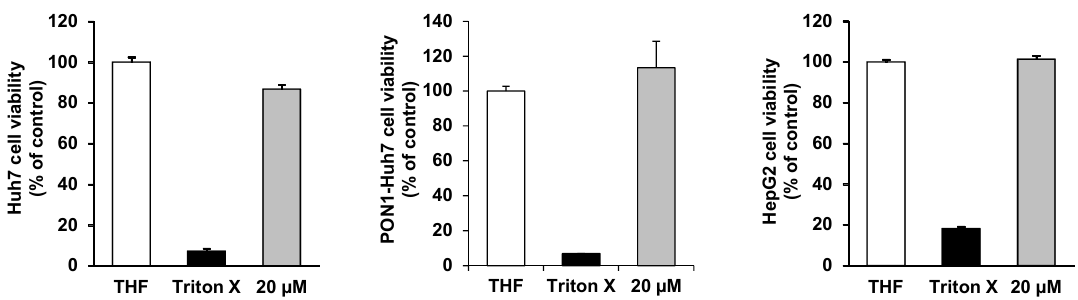
Figure 3. Effects of astaxanthin on cell viability in Huh7, PON1-Huh7, and HepG2 cells after 24 h incubation. Data are means + SD of at least two experiments performed in triplicate.